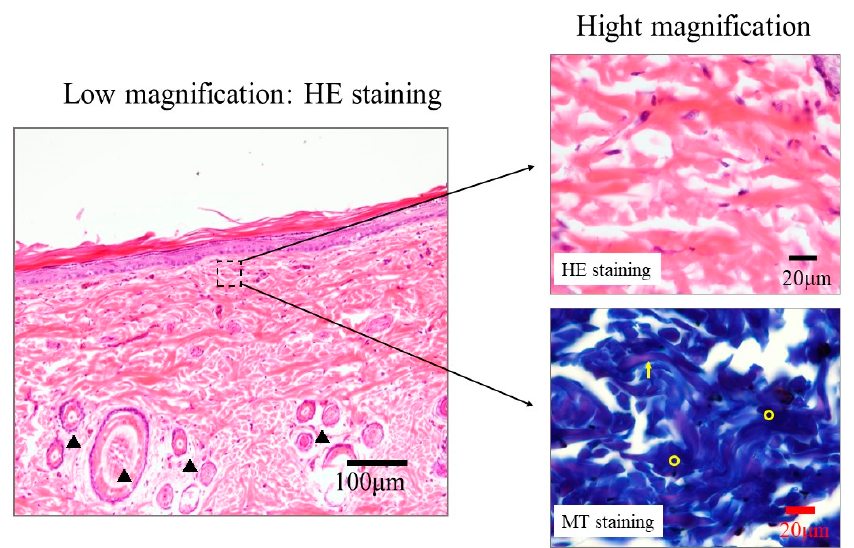
Figure 7. The images of HE- and MT-stained autologous skin tissue of a rat. The symbols of ○ , ↑ , and ▲ mean collagen fi ber, elastic fi bers, and hair follicle, respectively.